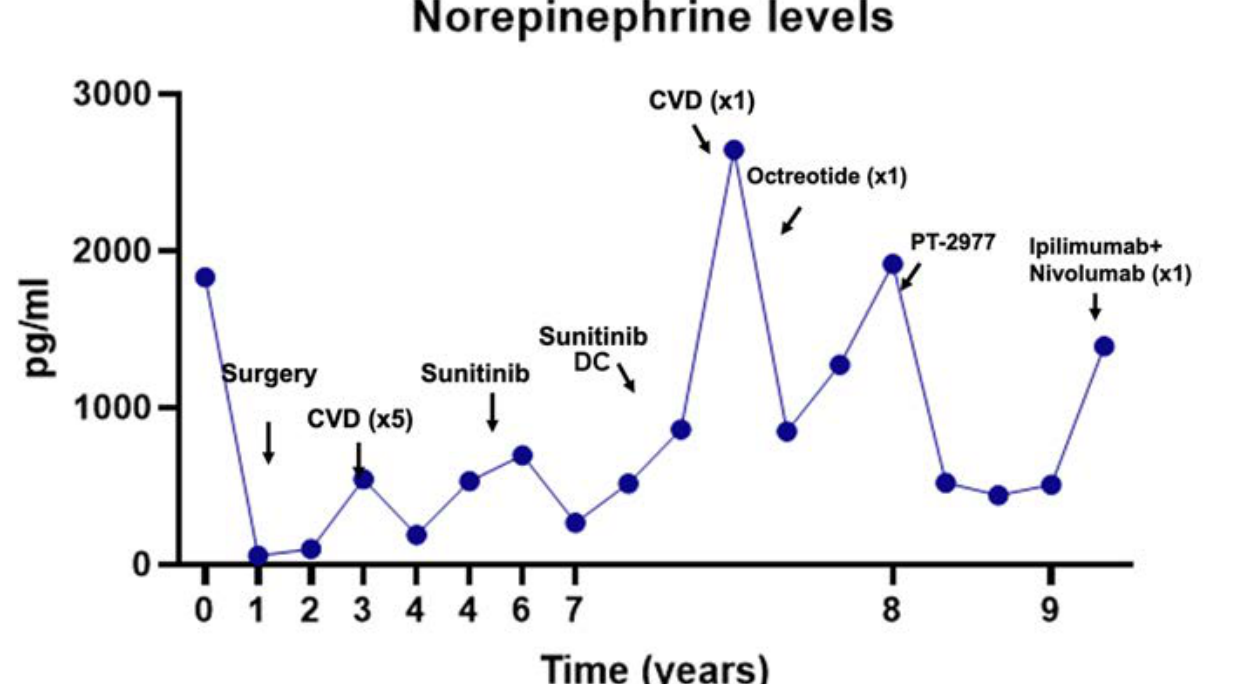
Figure 2. Plasma norepinephrine (NE) levels of a patient with a pathogenic germline SDHB mutation diagnosed with a retroperitoneal paraganglioma, who progressed with metastases and underwent multiple lines of treatment over the course of her disease. NE levels are tracked closely with the tumor burden and symptoms. Bone metastases were detected two years post-surgery. The patient received CVD followed by sunitinib, with the initial control of disease, however, both therapies were eventually discontinued (DC) due to adverse side effects. After disease progression, new attempts were made with sunitinib and CVD, although once again drugs were poorly tolerated. One dose of octreotide depot was given to attempt symptomatic control of the disease. Next, the patient was enrolled in the Phase 1 clinical trial for a HIF2 α inhibitor (PT-2977/ MK6484, NCT02974738). The patient had clinical, biochemical, cellular, and molecular responses mainly demonstrated by a decrease in NE, development of anemia, a common on-target effect of HIF2 inhibition, and reduced expression of HIF2 α target genes (not shown) and remained stable for 8 months. Despite this improvement, the disease progressed, and the HIF2 α inhibitor was discontinued. The patient initiated a trial with CTLA-4 and PD-1 inhibitors (NCT02834013) but only tolerated one cycle. Disease progressed rapidly and the patient died a few months later. This case illustrates two critical timepoints during disease evolution that remain gaps in the field: determining the basis for the rapid increase in disease burden and emergence of resistance to targeted therapy could inform treatment choices in patients with metastatic pheochromocytoma and/or